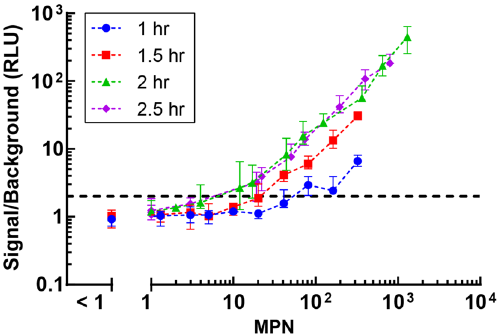
Figure 3. Median luminescence signal of 8 replicates with interquartile range normalized to phage only background as a function of MPN/well for 1, 1.5, 2, and 2.5-h phage incubations using ATCC 25922 and the 8-phage cocktail. MPN values were determined by Quanti-Tray/2000, in triplicate. The dashed line represents values at 2× background.